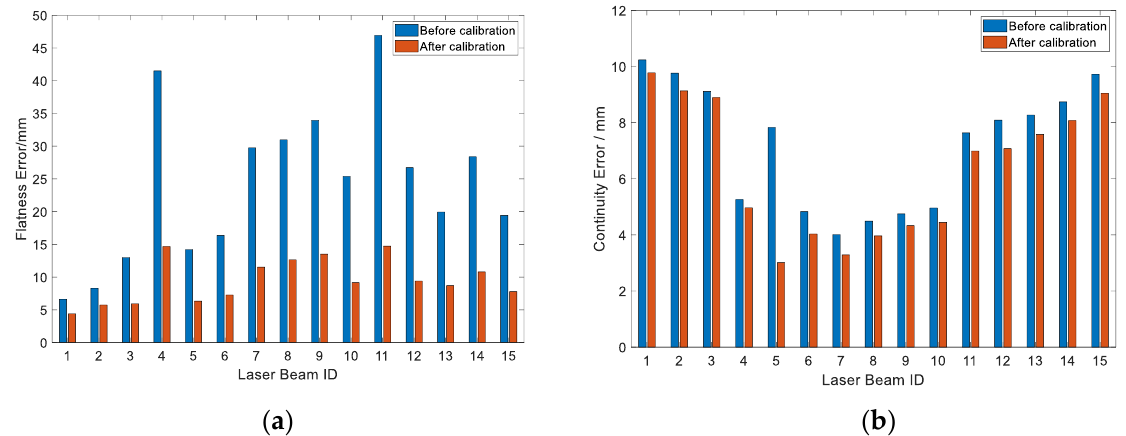
Figure 10. Errors changes of plane 1 before and after calibration: ( a ) Flatness error change of each point cloud block. ( b ) Continuity error change of each point cloud block.